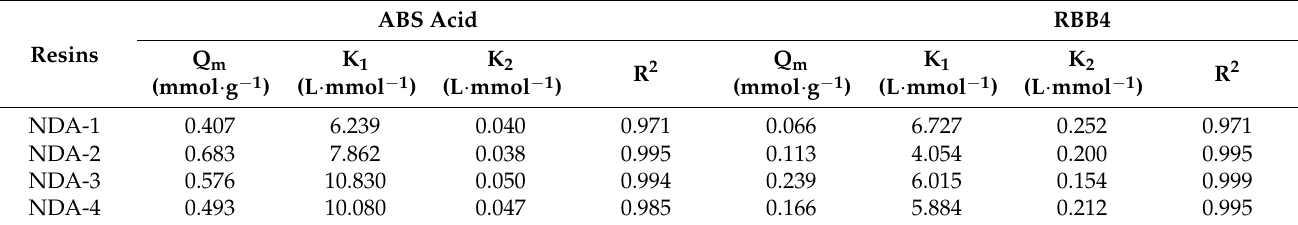
Table 4. The corresponding parameters of three-parameter multilayer adsorption model. ABS Acid Resins